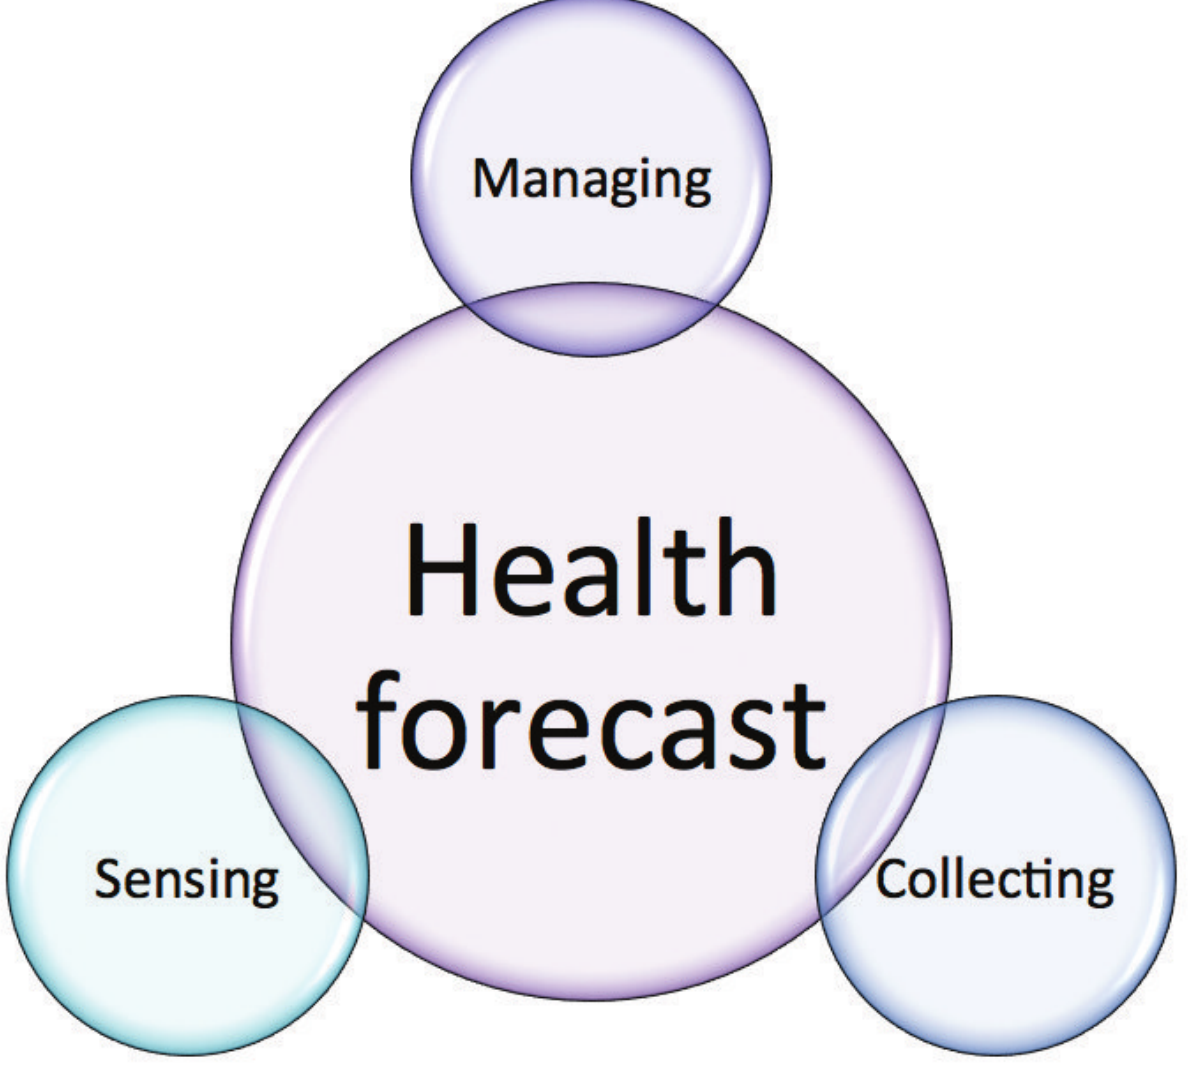
Figure 3. The task of sensing, collecting, and managing the data gains a larger significance when combined together with the possibility to produce new and valuable information on the health status of single individuals or entire